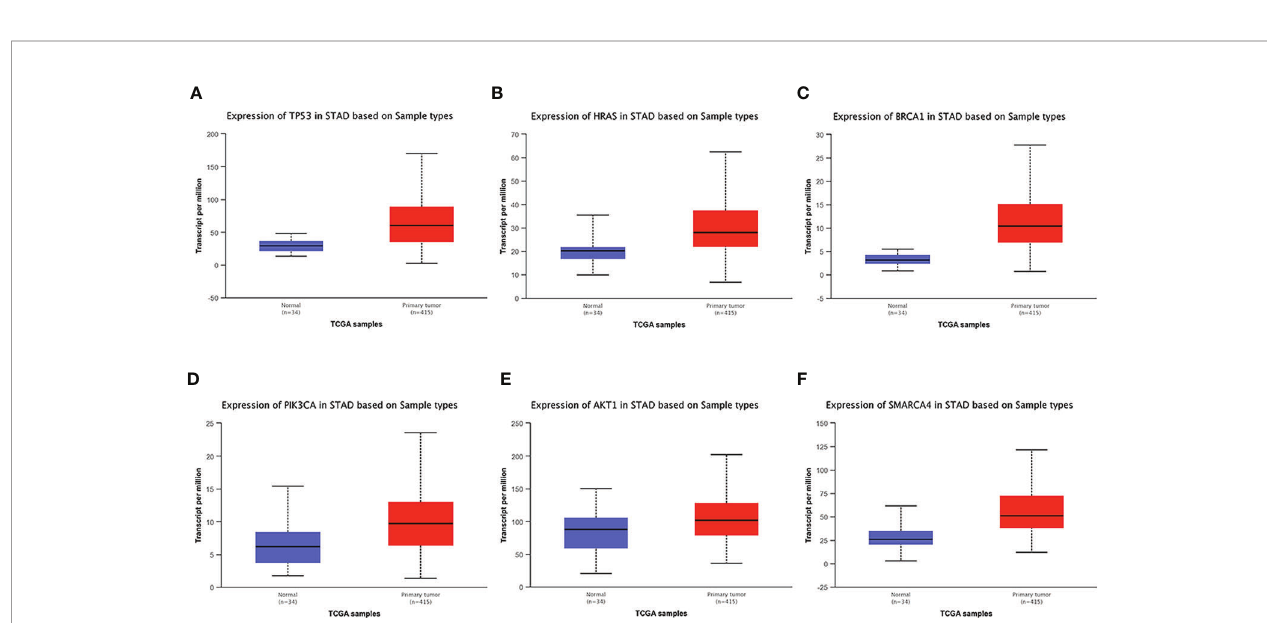
FIGURE 8 | Analysis of the expression of key mutated genes. Six key genes are highly expressed in gastric cancer tissues compared with normal tissues. (A) TP300. (B) HRAS. (C) BRCA1. (D) PIK3CA. (E) AKT1. (F)